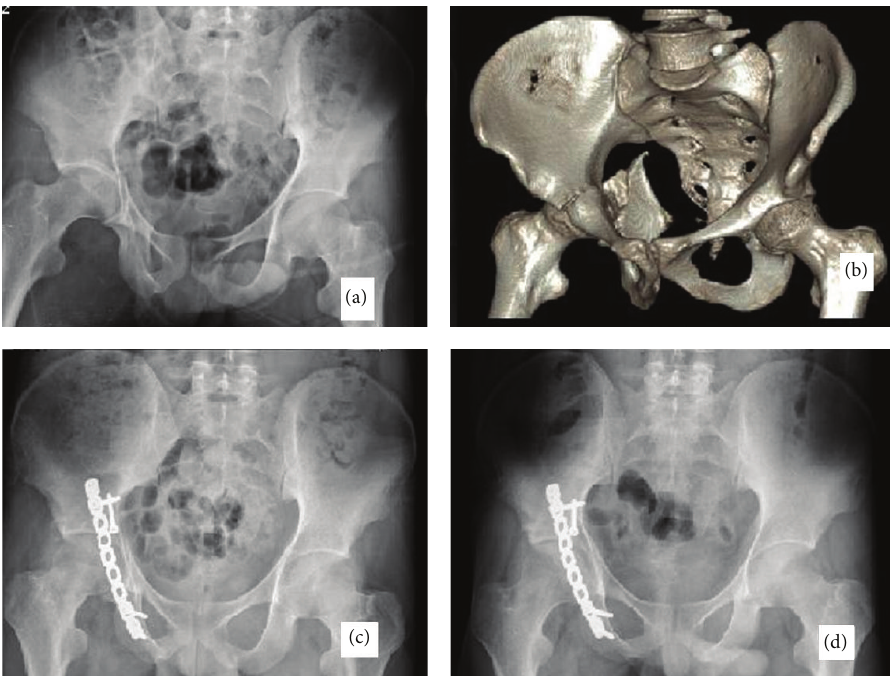
Figure 1: A 26-year-old male patient having acetabular fracture. (a) Preoperative X-Ray. (b) Preoperative 3D-CT scan. (c) Early postoperative X-Ray. (d) Late postoperative X-Ray (24 months).